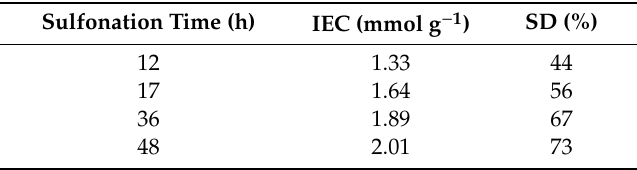
Table 1. IECs and SDs of the prepared